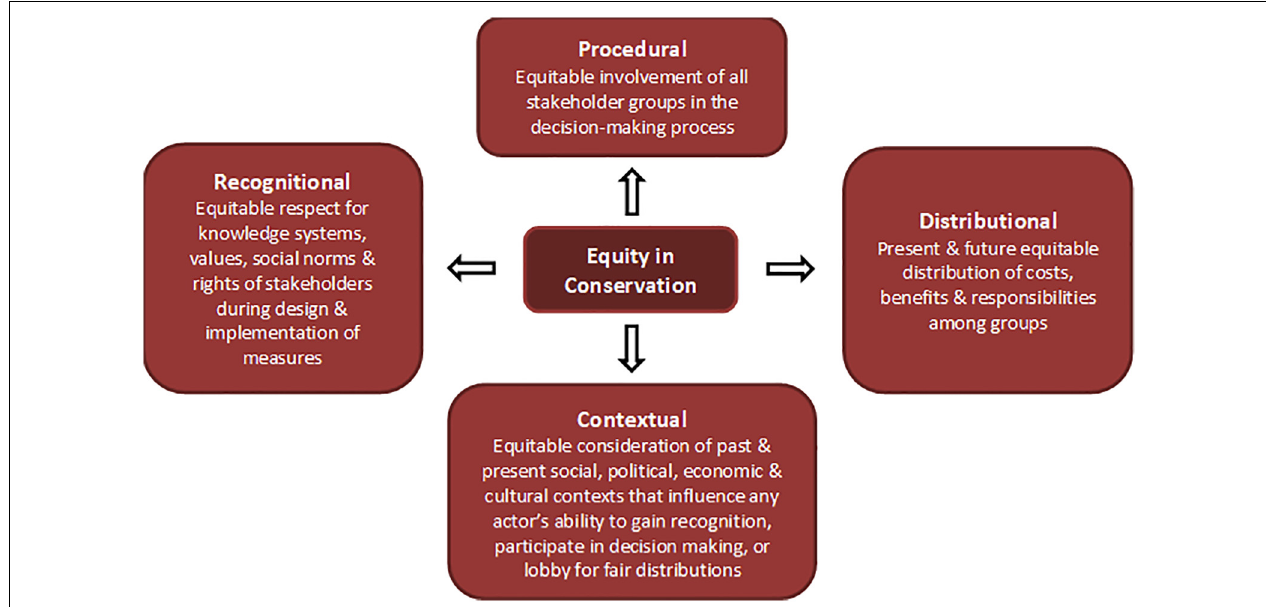
FIGURE 4 | The four dimensions of equity in conservation (based on McDermott et al., 2013; Law et al., 2018).